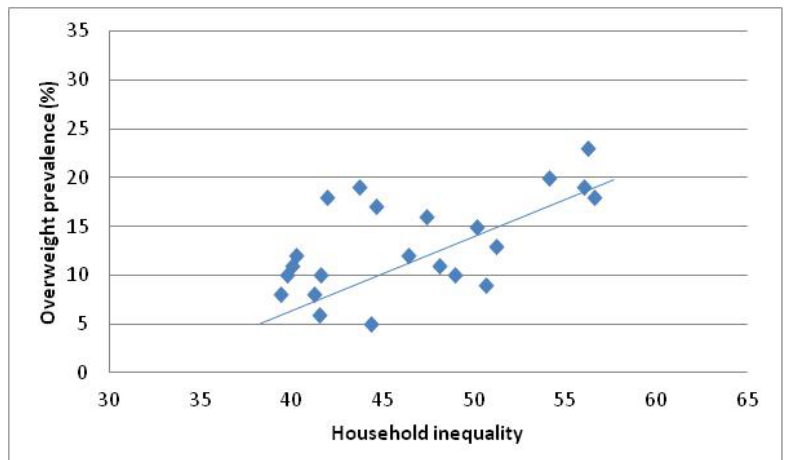
Figure 2. ( a ) Household income inequality by child self-reported overweight; ( b ) Household income inequality by child measured